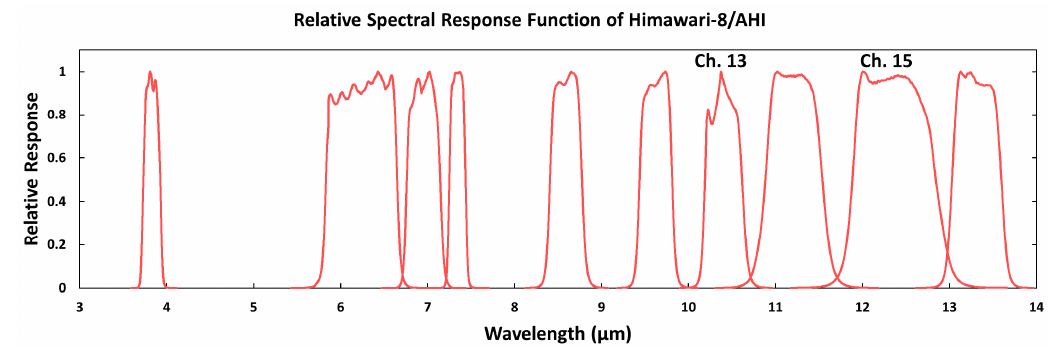
Figure 1. Relative spectral response function of Himawari ‐ 8/AHI infrared channels.